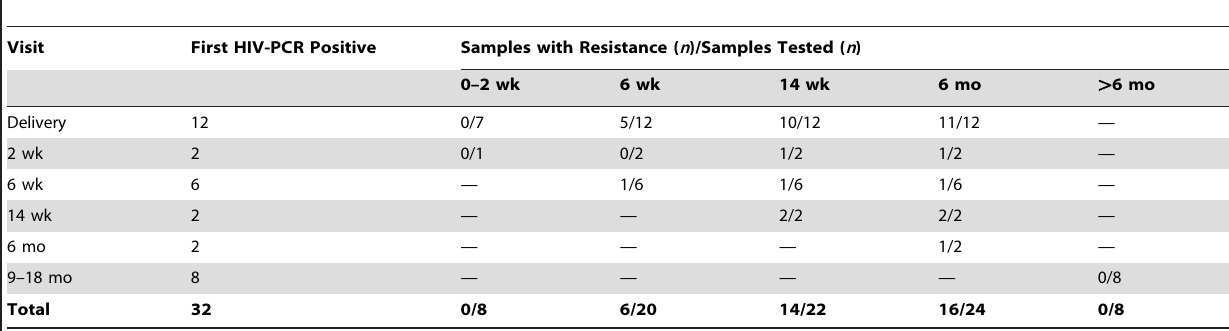
Table 1. HIV-1 drug resistance emergence among breastfeeding infants in the Kisumu Breastfeeding (KiBS) trial, Kenya, 2003–